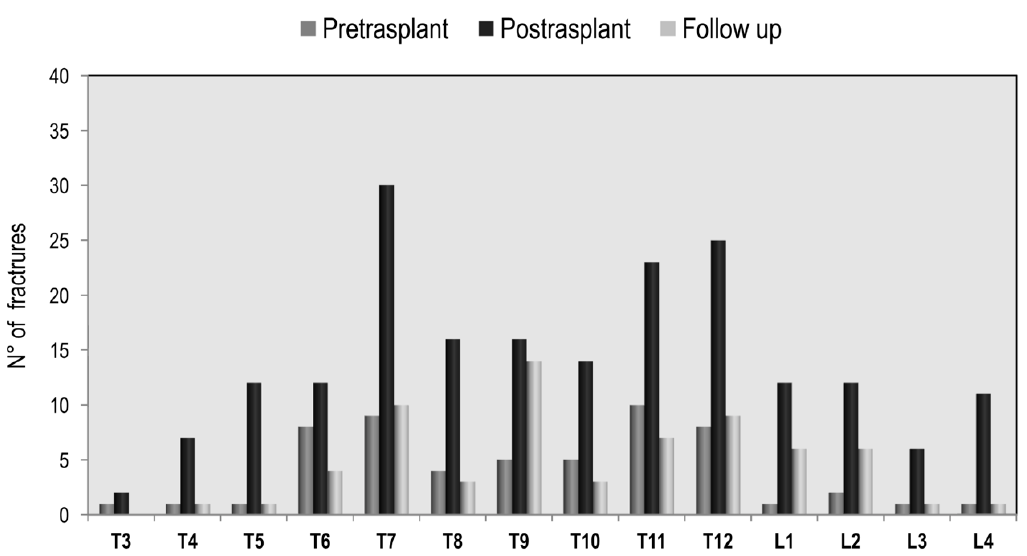
Figure 4. Distribution of vertebral fractures in lung transplantation.